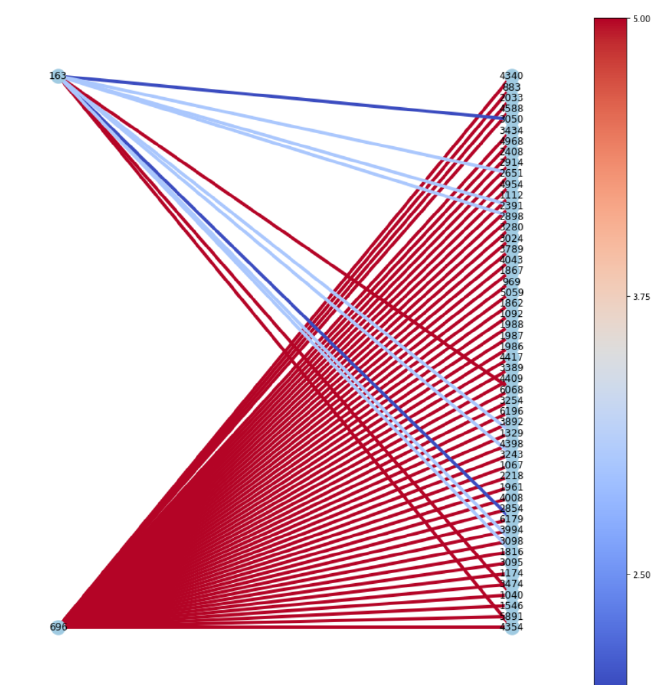
Figure 9. A visualized subgraph when the predicted score is